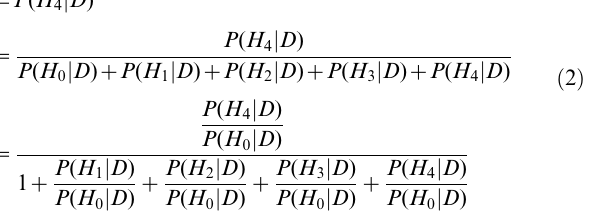
lower variant density. The causal variant is included in the Illumina 660W panel.